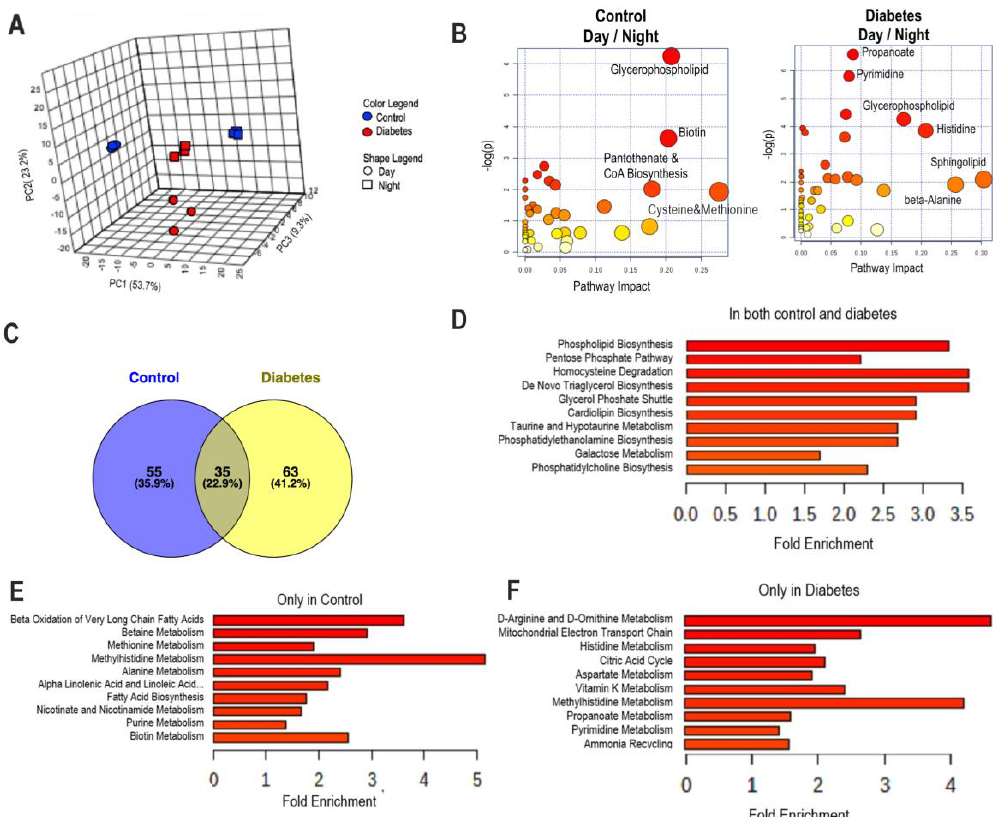
Figure 2. Global metabolomic analysis of plasma metabolites. Blood samples were collected at ZT5 (day) and at ZT17 (night) from 10-month-old db / db (diabetic) and aged-matched db / m (control) mice. Untargeted global metabolomics analysis was performed with the Metabolon Platform (Metabolon Inc). Statistically significant di ff erent metabolites were used for the analysis with MetaboAnalyst. ( A ) PCA analysis. ( B ) Metabolic pathway analysis of metabolites that were di ff erent in the transition from day to night in control and diabetic groups. ( C ) Venn graphs of metabolites that were di ff erent in the transition from day to night in control and diabetic groups. ( D ) Enrichment analysis of metabolites that similarly changed in the transition from day to night in control and diabetic groups. ( E ) Enrichment analysis of metabolites that changed in the transition from day to night only in control. ( F ) Enrichment analysis of metabolites that changed in the transition from day to night only in diabetes. n = 3 per time point per